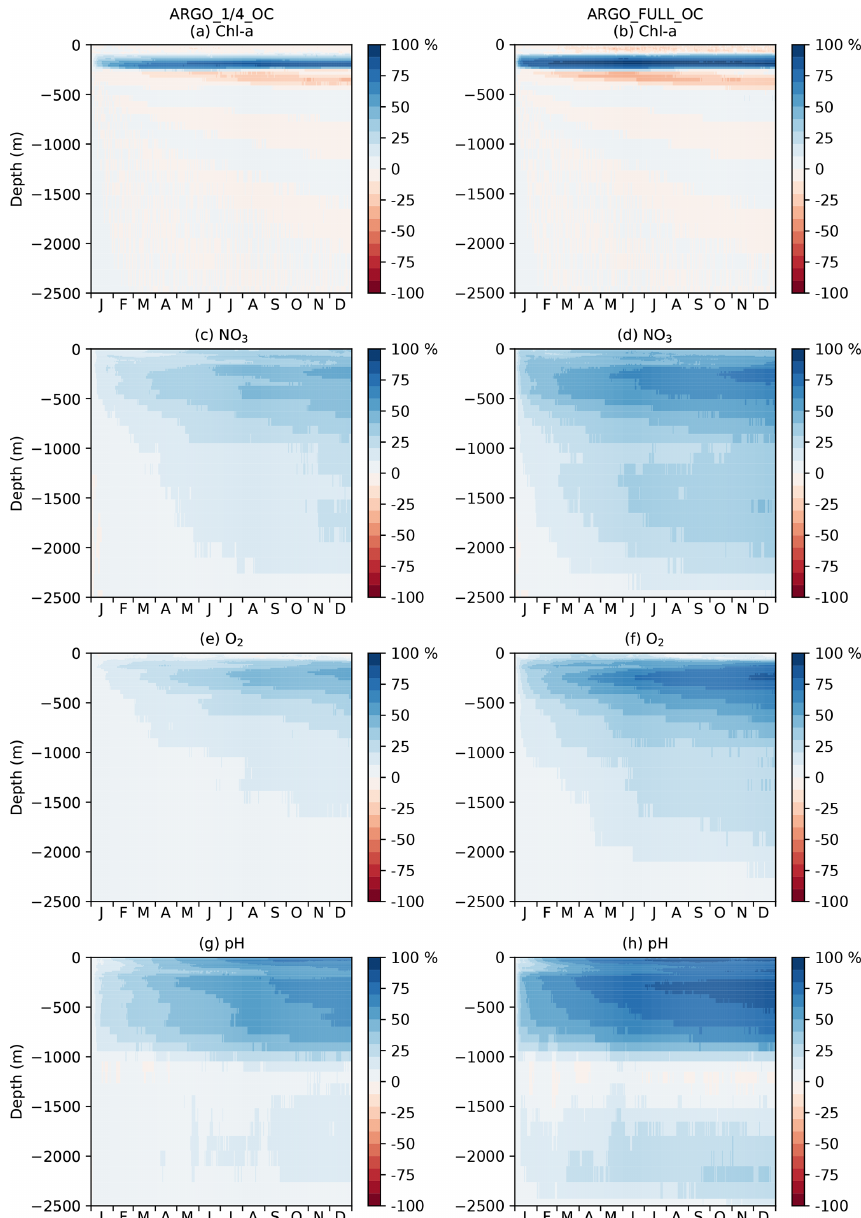
Figure 12. Hovmöller diagram of daily MAE red_% over OC with depth in the tropical Pacific for Chl a , NO 3 , O 2 , and